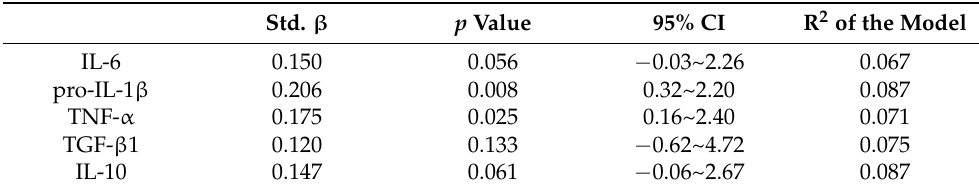
Table 2. Association of plasma extracellular vesicle cytokine levels with the diagnosis of Parkinson’s disease after adjustment for age and sex.